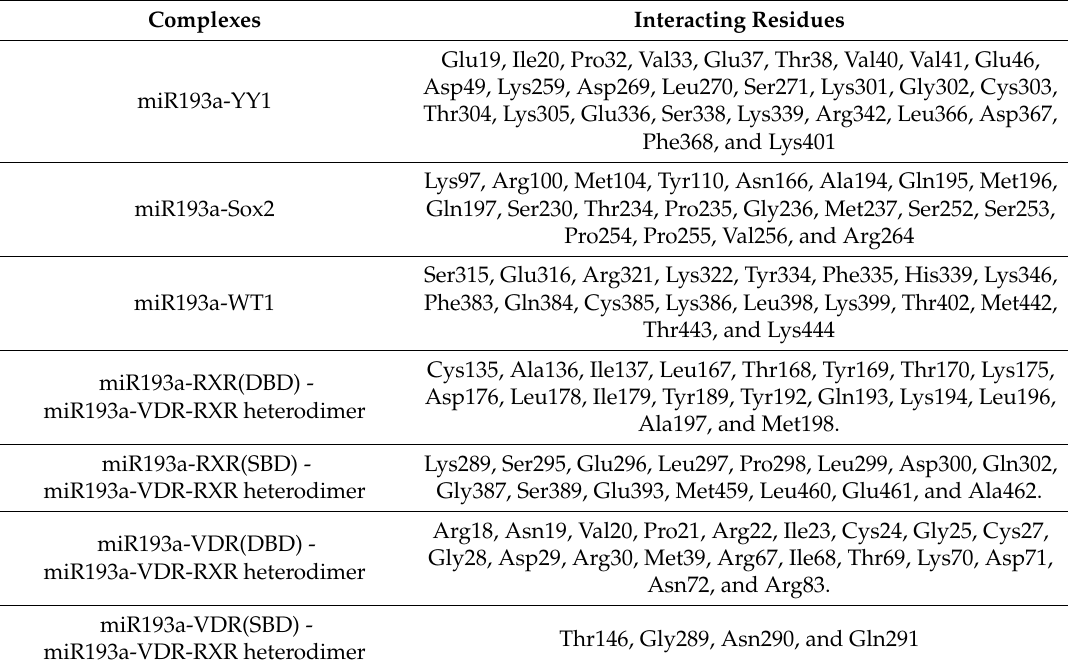
Table 2. Interacting residues in the DNA-Transcription factor